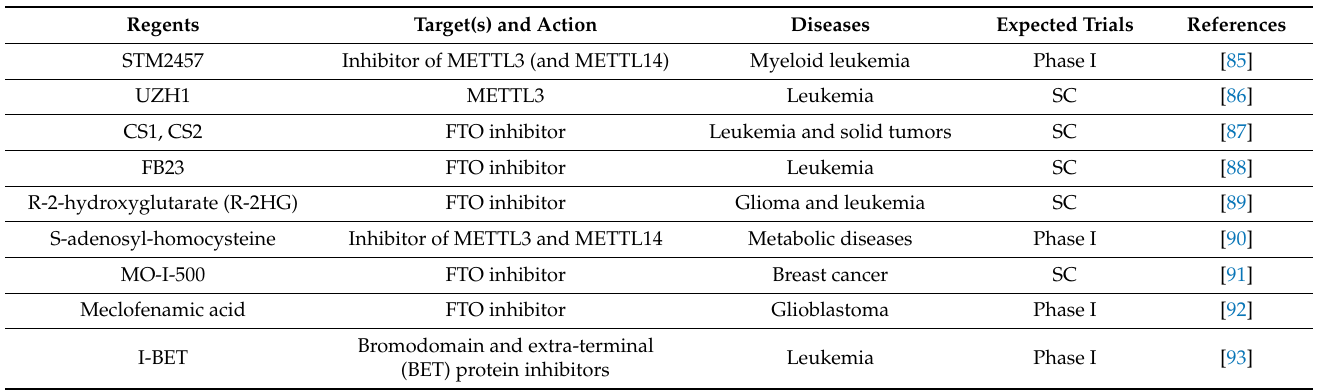
Table 2. Reagents targeting RNA modifications.